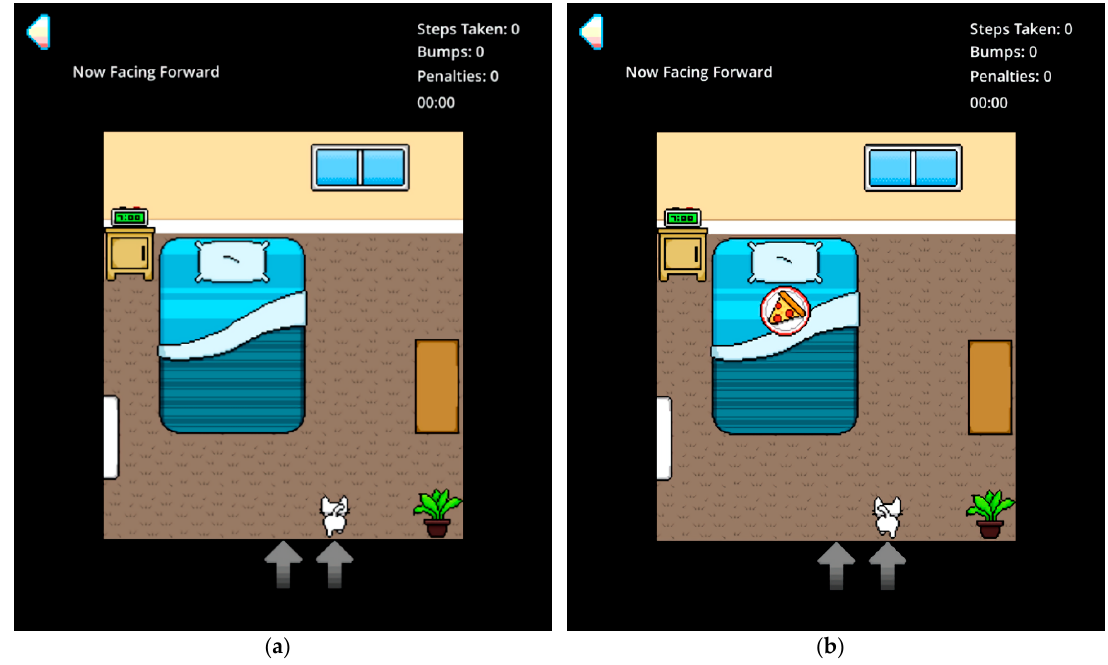
Figure 4. Hungry Cat, bedroom level: ( a ) in exploration mode; and ( b ) in food finding mode.